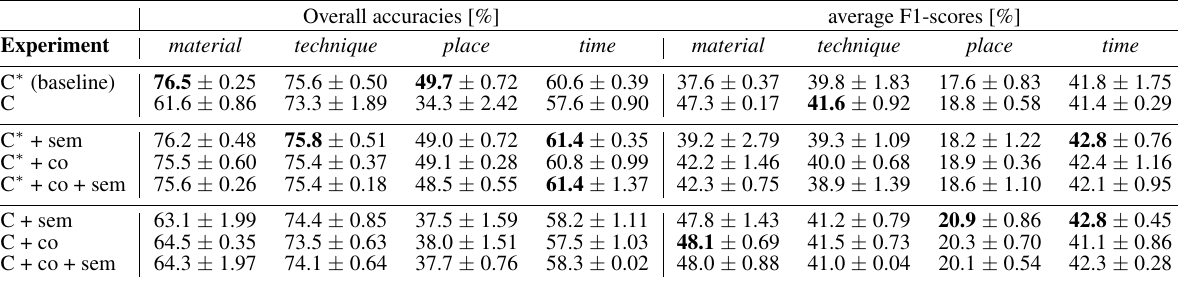
Table 4. Overall accuracies [%] and average F1-scores [%] of the experiments. The quality metrics averaged over three runs are presented as well as the corresponding standard deviations. The best average quality metric per variable is highlighted in bold font.